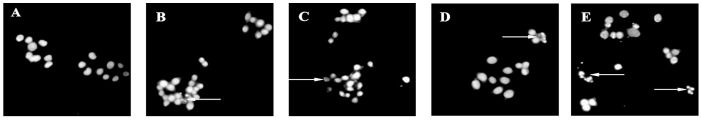
Effect of laminarin on LoVo cell morphology. LoVo cells were treated with (A) Dulbecco’s modified Eagle’s medium/F12 culture medium as a control and (B) hydroxycamptothecin (5 μg/ml) as a negative control, as well as (C) low (400 μg/ml), (D) middle (800 μg/ml) and (E) high (1600 μg/ml) concentrations of laminarin. Arrows indicate apoptotic bodies.